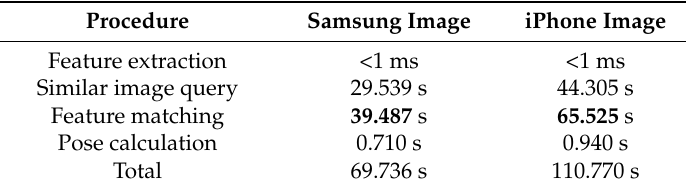
Table 8. Computational time of each